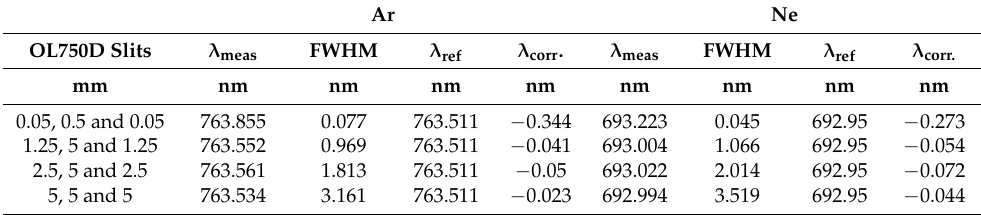
Table 3. Wavelength correction values for different slits configurations of double monochromator OL750D.